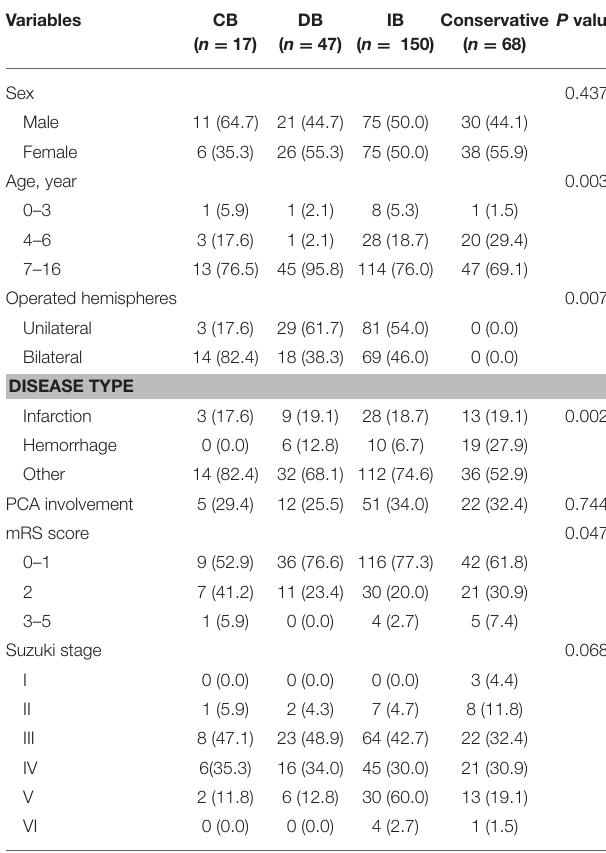
TABLE 2 | Comparison of clinical and imaging features between MMD patients with different management